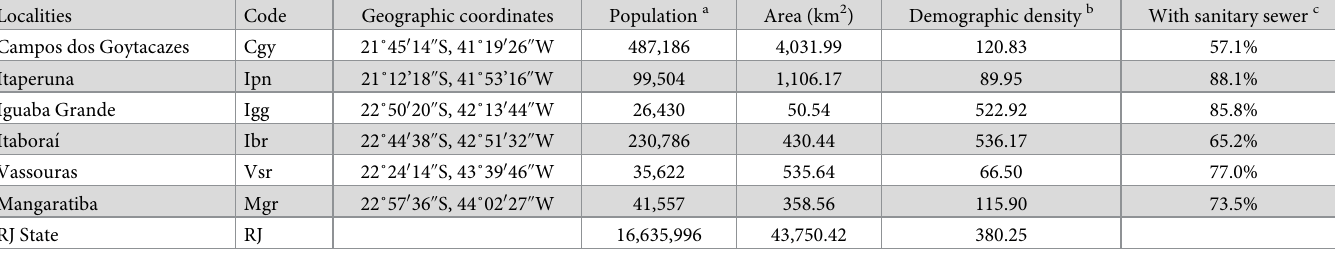
Table 1. The localities of sampling eggs of Aedes spp. for this study and their geographical